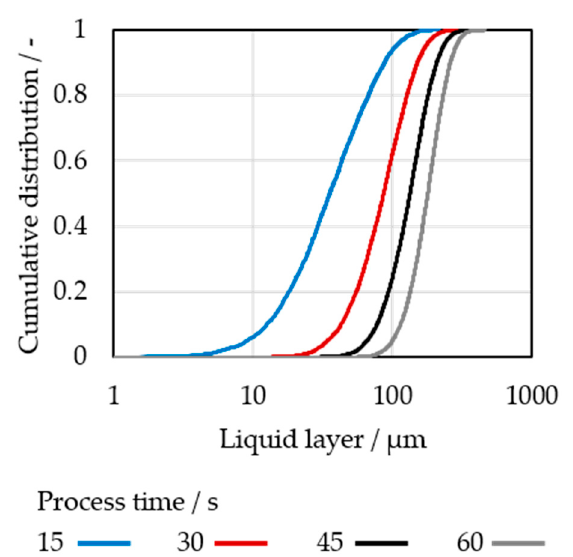
Figure 9. Cumulative distribution of the liquid layer thickness on the particles during liquid injection (case II).